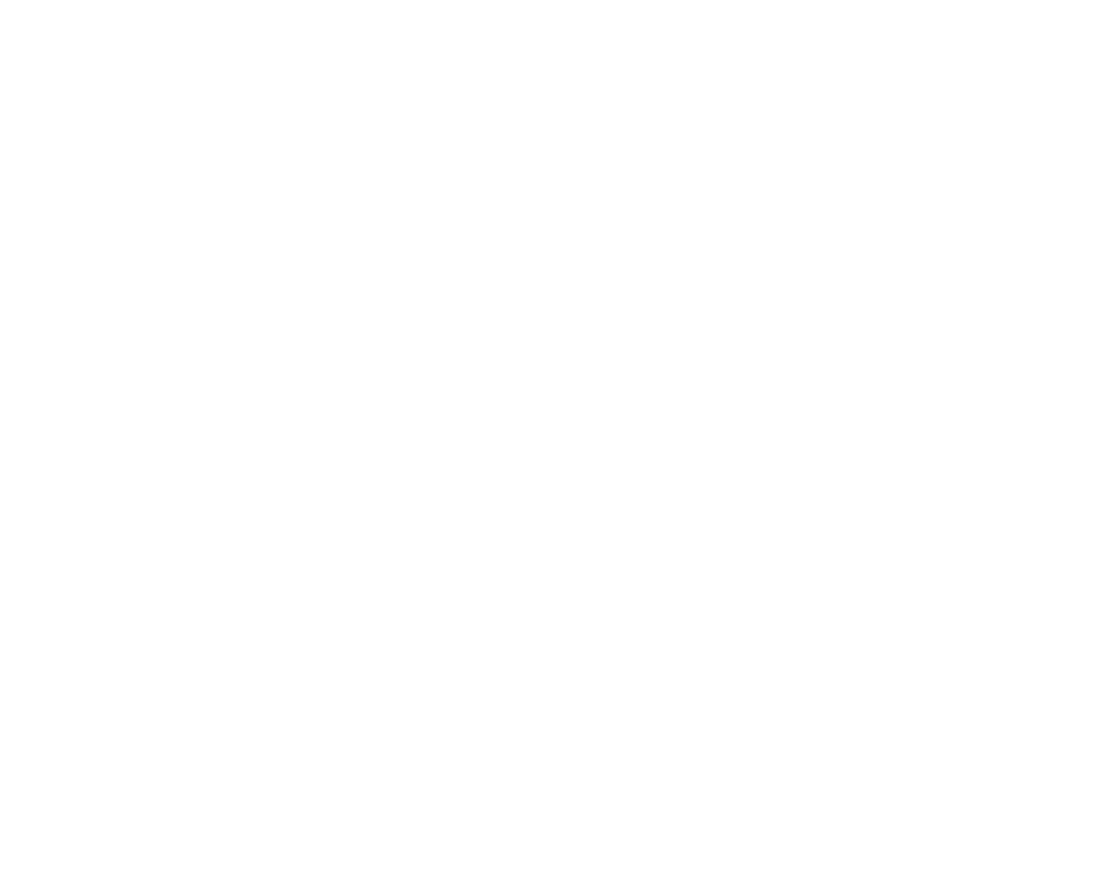
(C) Cortical vessel with inflammation and fibrinoid necrosis, 200 × . (D) Vessel